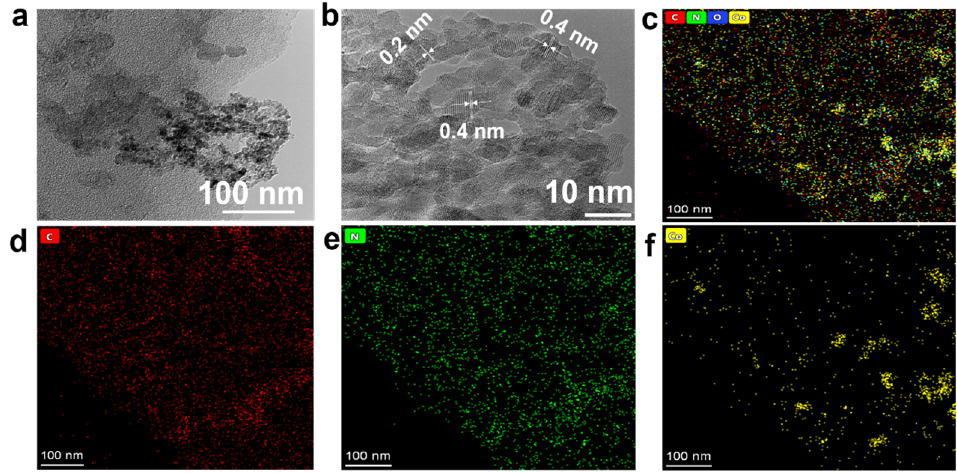
Figure 3. ( a ) TEM image of Co/N-C-900, ( b ) HRTEM image of Co/N-C-900, ( c ) EDS merged mapping image of C, N and Co, ( d – f ) EDS mapping images for C, N and Co,